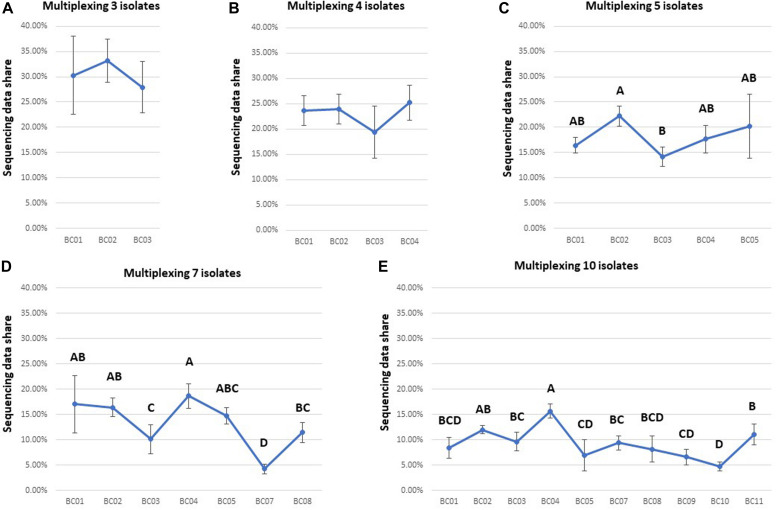
Comparison of the data yield of each isolate multiplexed in one flow cell for each multiplexing strategy (sequencing time: 48 h). Based on the statistical analysis results of Tukey HSD test, barcodes with different letters were significantly different (P-value < 0.05) from each other in data yield. Ideally, data share of each isolate was expected to be 31, 23, 18, 13, and 9% in (A–E).